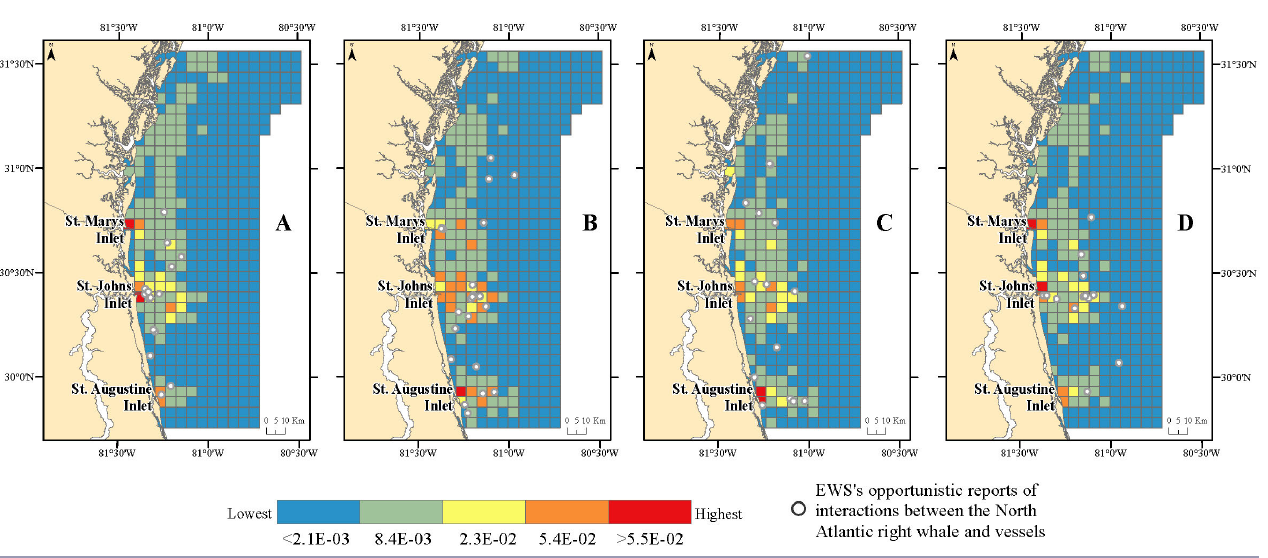
Fig. 4. Monthly encounter risk (relative probability of a whale and a recreational vessel cooccurring in the same grid cell) for North Atlantic right whales and recreational vessel for December (A), January (B), February (C), and March (D). White dots represent Early Warning System’s (EWS) opportunistic reports of interactions between right whale and vessels. Sampling grid cells are 5.56 x 5.56 km cells ( n =